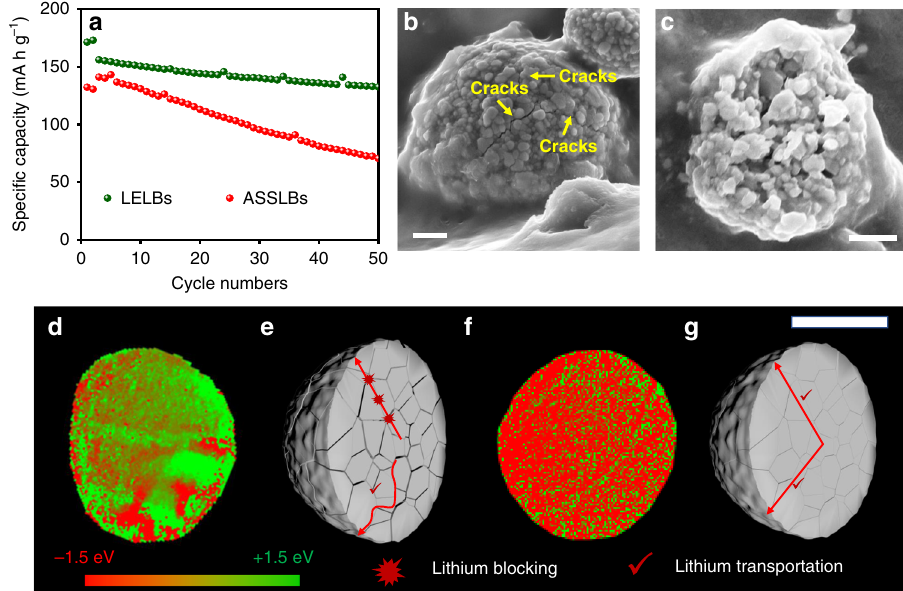
Fig. 3 Structure and SOC distribution of the cycled cathode particles. ( a ) Comparison of the cycling stability of NCM electrodes in the ASSLBs and LELBs at 0.5 C after activation. ( b, c ) Typical SEM images of the cycled NCM electrodes in the ASSLBs, scale bar, 2 μ m, 3 μ m. ( d ) 2D TXM-XANES mapping of cycled NCM particle in the ASSLBs, and ( e ) diagram of the effects of cracks on lithium transportation. ( f ) 2D TXM-XANES mapping of cycled NCM particle in the LELBs, and ( g ) diagram of the slight effects of microcracks on lithium transportation. Scale bar, 10 μ